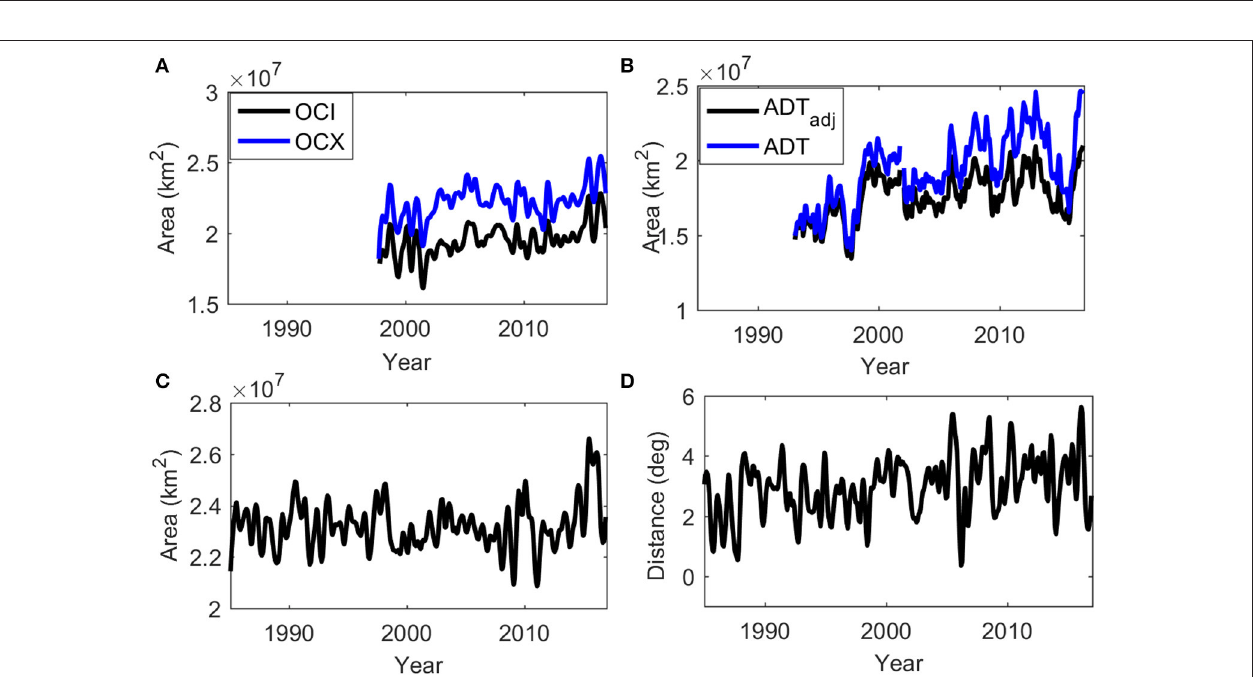
FIGURE 3 | Temporal trends of North Pacific subtropical gyre dynamic geography indices showing (A) areal extent calculated from oligotrophic threshold chl a across different satellite ocean color algorithms; (B) areal extent (expansion/contraction) calculated from satellite altimetry derived dynamic topography with and without adjustment for steric sea-level rise; (C) merged model and satellite seascape extent; (D) distance of Station ALOHA to the edge of the merged modeled and satellite subtropical seascape (isolation). All series were smoothed using a 12-month LOESS filter. Trends calculated over various durations are reported in Table 1